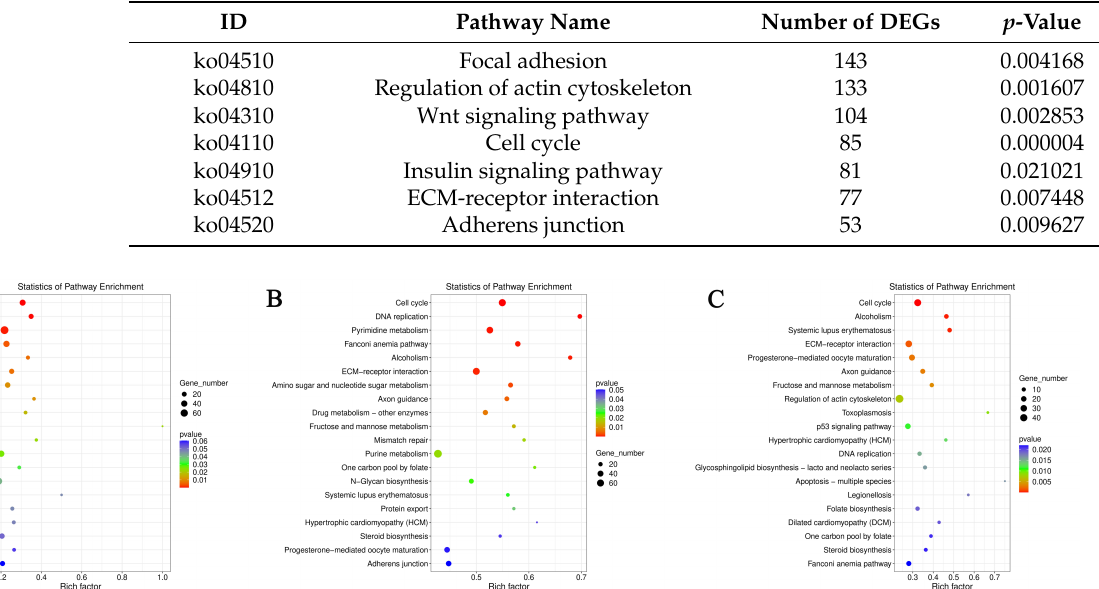
Figure 9. KEGG pathways of differentially expressed genes (DEGs) enrichment in breast muscle. ( A ) E15_BM vs. E21_BM; ( B ) E15_BM vs. E27_BM; ( C ) E21_BM vs. E27_BM.